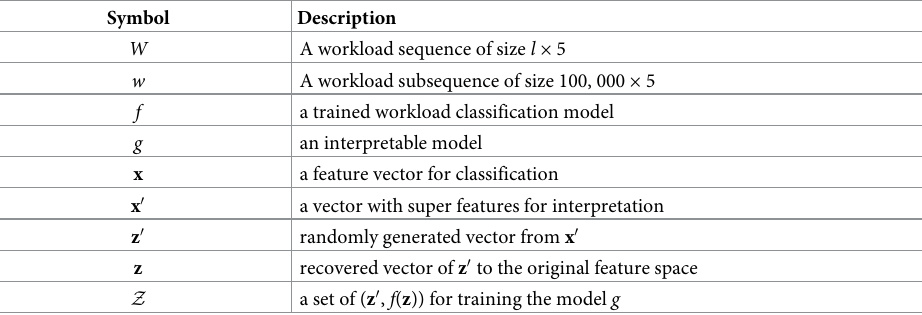
Table 1. Description of